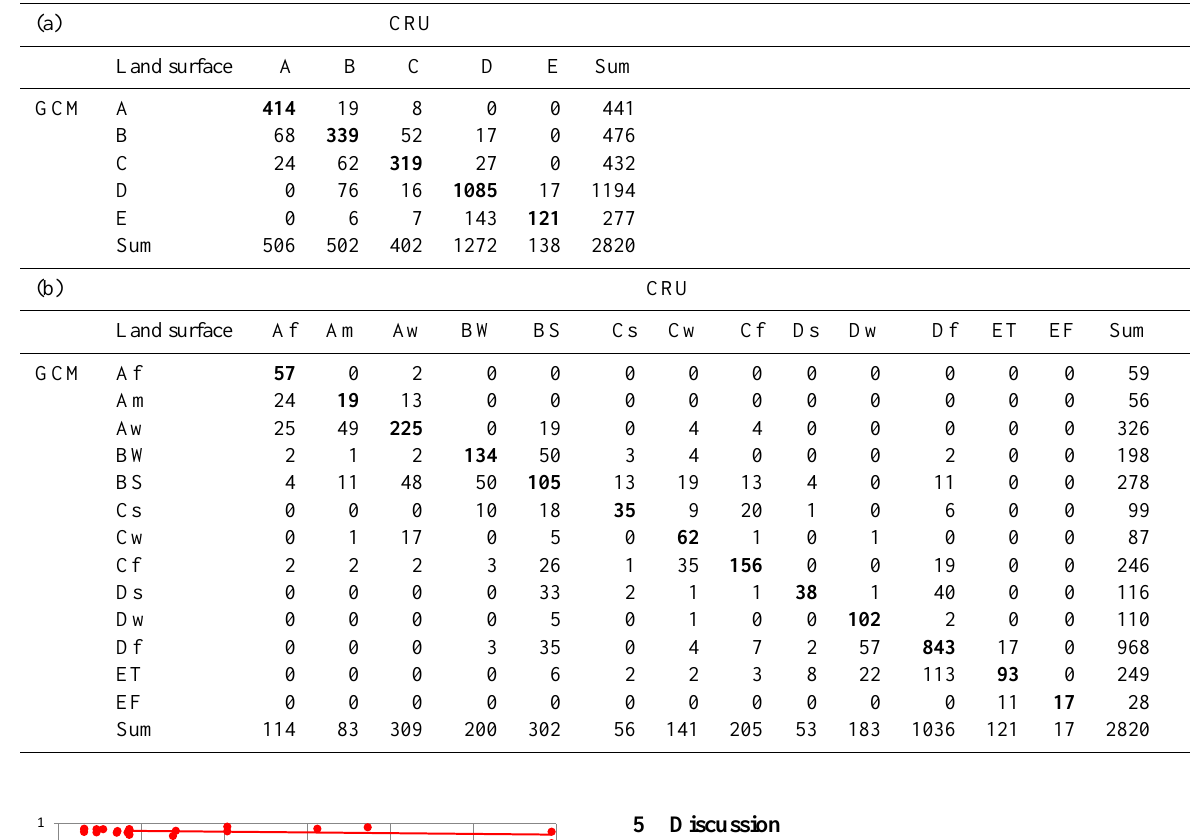
Table 6. Köppen–Geiger climate estimated by MPI(3) compared with the observed Köppen–Geiger climate for (a) the one-letter and (b) the two-letter climate classification. Bold values are correctly classified grid cells.